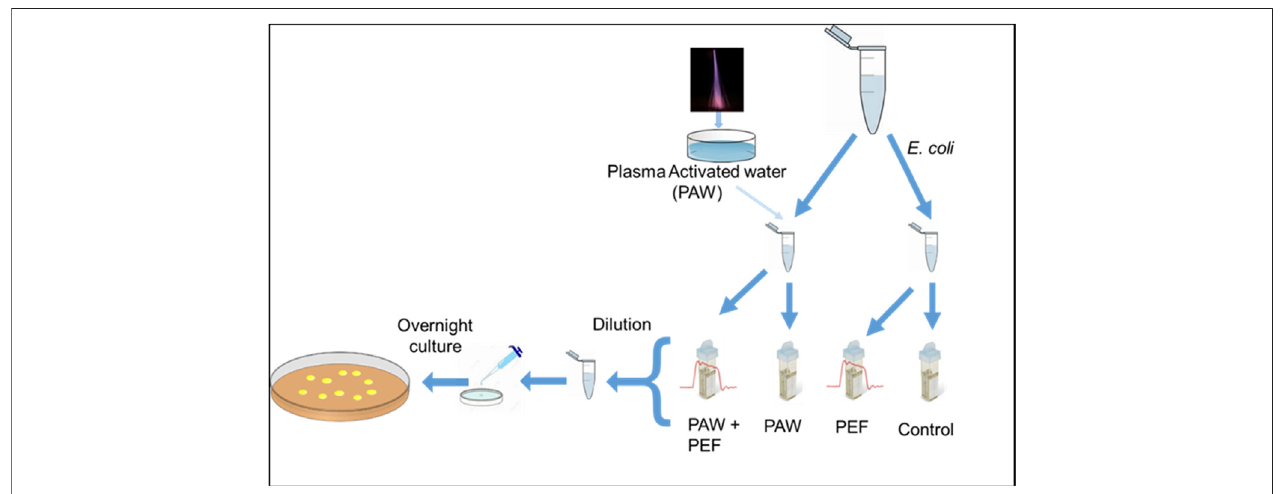
FIGURE 1 | Schematics of the experiment to investigate the antibacterial effect of PEF, PAW, and the coupled PAW + PEF.